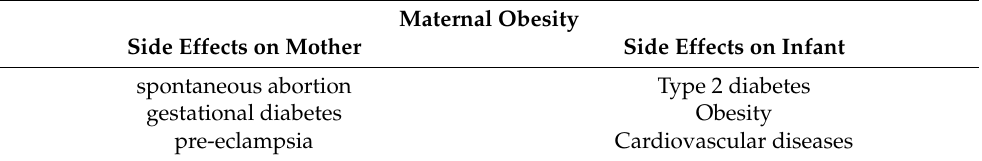
Table 1. Effect of maternal obesity on the mother-baby